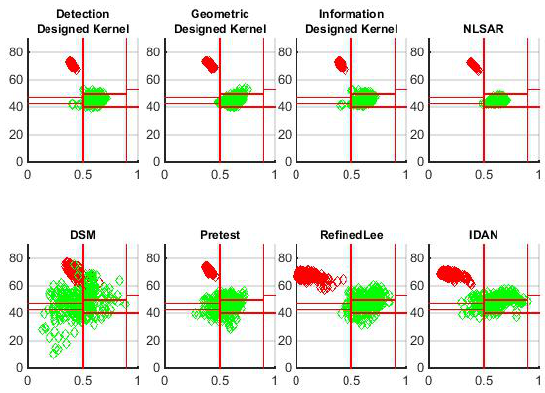
Figure 11. Entropy-alpha unsupervised classification test on vegetation scatterers and double bounce scatterers According to the unsupervised classification, the designed kernel with the three similarity measures and NLSAR produce correct and compact classification results that means better preservation of polarimetric Figure 9. Decomposed entropy of the some pattern in filtered data